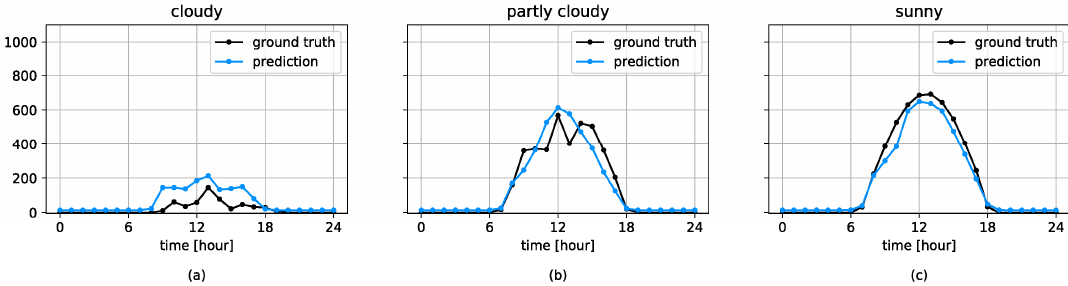
Figure 5. Three-hour-ahead LSTM predictions versus observations in three typical days with different cloudiness: a cloudy day ( a ), a partly cloudy day ( b ), and a sunny day ( c ). Values refer to the test year (2019).